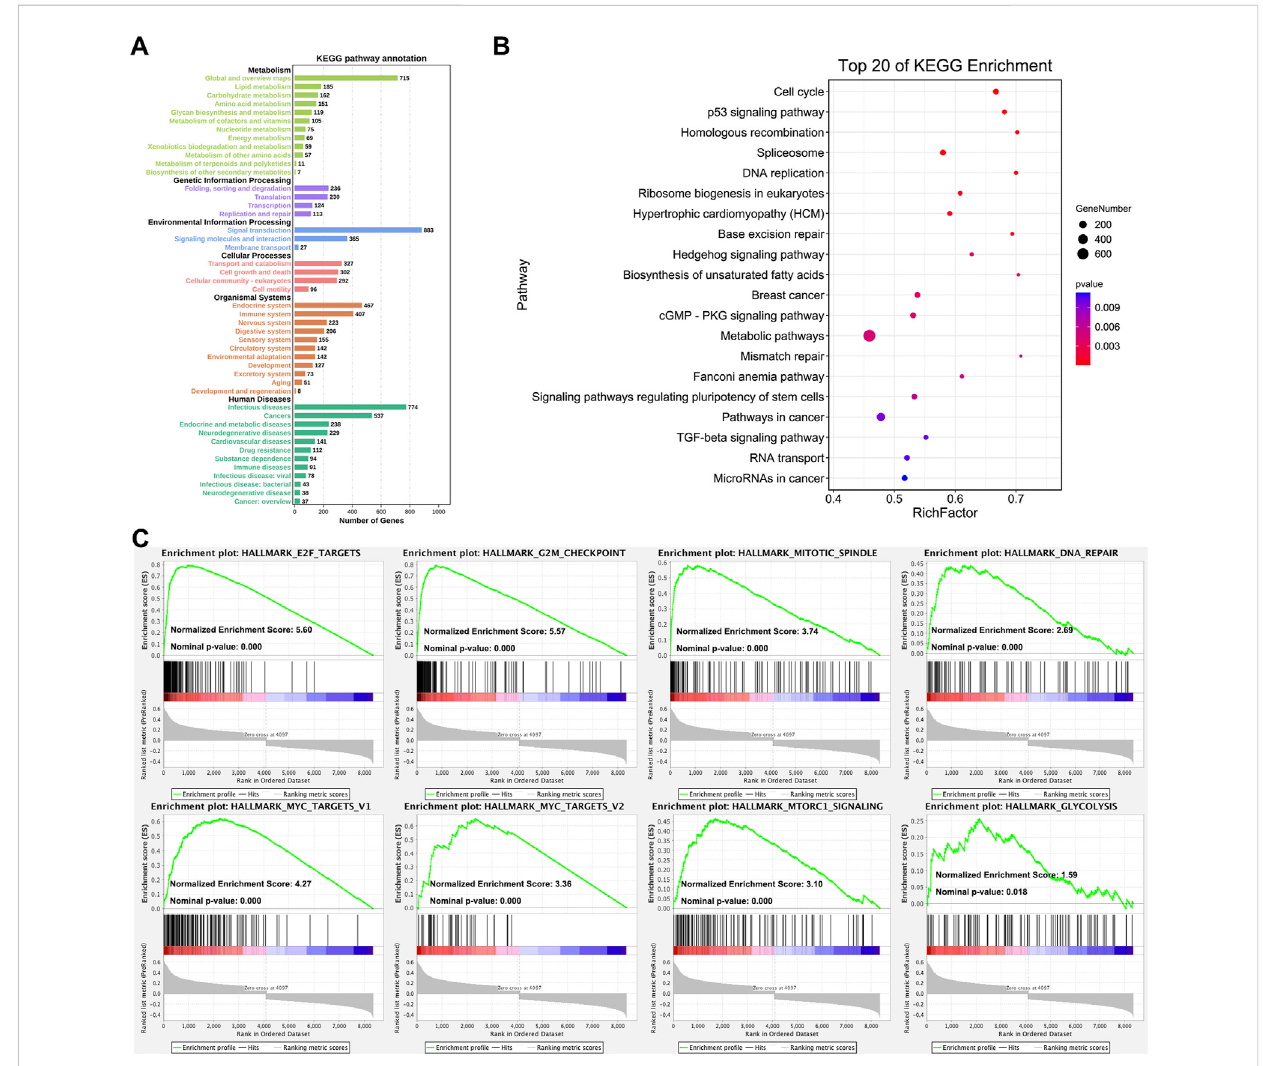
FIGURE 3 AnalysisofCHAF1A ’ sfunctionalrolesandpotentialmechanisms. (A) TheKEGGannotationofCHAF1Aco-expressiongenenetworkwasindicatedby OmicShare. The length of the bar stands for the number of genes enriched in each function. (B) The top 20 pathways of CHAF1A co-expression gene network were generated by using OmicShare. The size of node stands for the exact number of genes that enriched in pathway, and the colour stands for p -value. (C) The enrichment of cancer hallmarks based on the CHAF1A co-expression gene network using